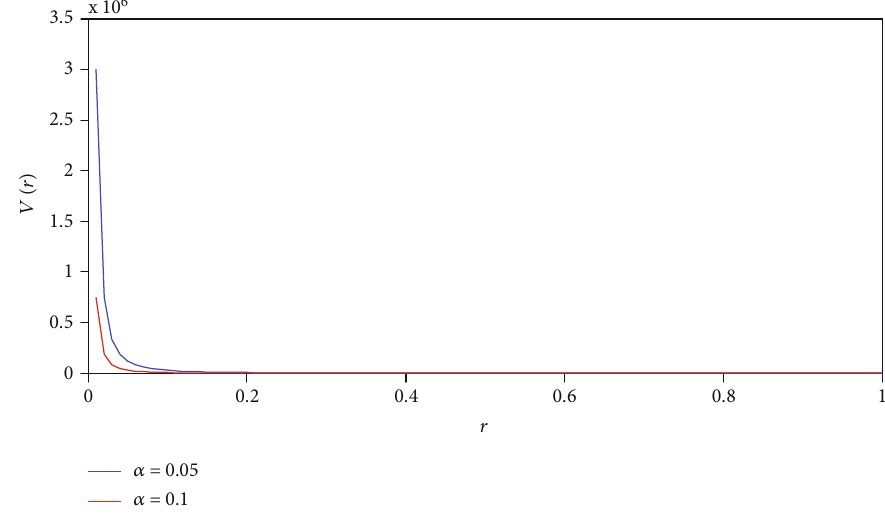
Figure 4: The Eckart plus Hulthen potential ð eV Þ in terms of r ð A 0 Þ for V